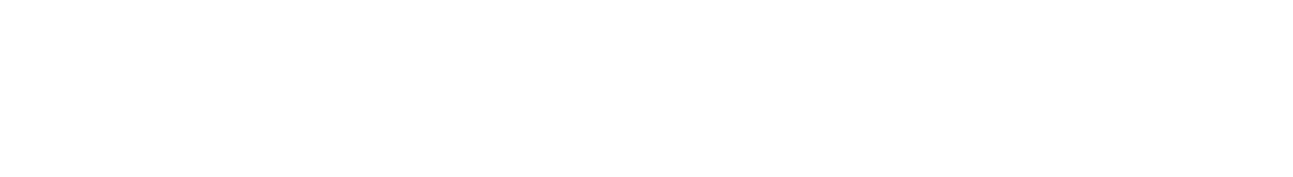
FIGURE 2 Basin bifurcations of the stable fixed point O=(0, 0), observed in the regime of noninvertibility of the map T, for tip 2.5, g --0.5, c 2.3, a 1.8 and by increasing c from the value 0.49. As explained in the text, the critical curves of the map allow one to explain the qualitative changes in the basin structure. At c 0.49 in (a), where the basin of the origin, the white region/3(O), is a simply connected area. At c =0.51 in (b) and (c), where the grey region /3() crosses the critical curve U, entering the region Z3 and /3(0) is a multiply connected area. At c- 0.533 in (d), where a new crossing of the boundary L causes the appearance of new holes. A different dynamic effect is associated with a similar crossing by the hole S_ 1: in (e), where c 0.534, it is shown that differently from the previous cases the hole Q_ generated by the new crossing is now in the region Z3, and thus it has three distinct rank-1 preimages, each of which has one or three preimages, so that a drastic increase in the numbers of the holes is observed, leading to an increasing complexity in the structure of the basin/3(0). This kind of bifurcation also occurs in a "backward" way, with the effect of decreasing the number of holes, as shown in (f), obtained for